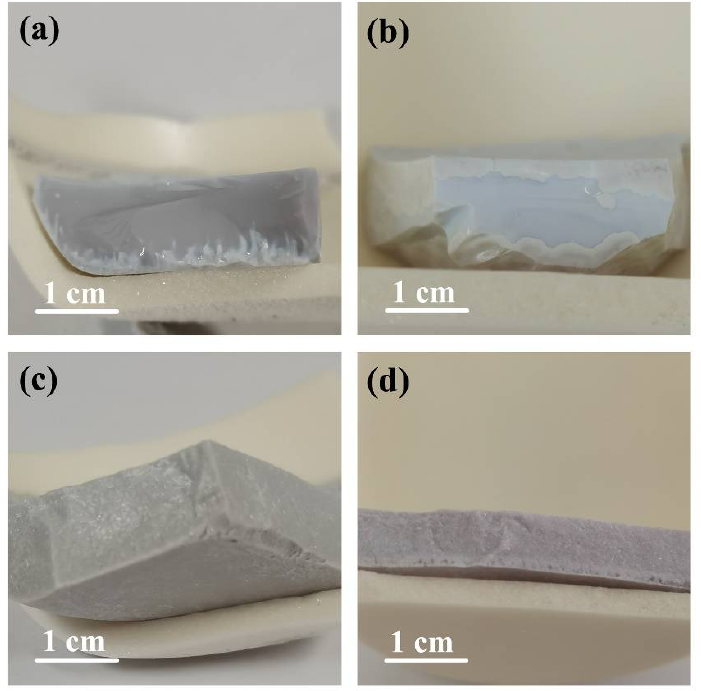
Figure 5. Appearance of the glass-ceramics: ( a ) CTZ-20; ( b ) CTZ-30; ( c ) CTZ-40 and ( d ) CTZ-50.